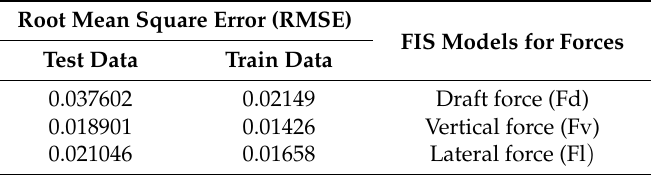
Figure 8. Comparison of predicted data ( a ) with training data and ( b ) with checking data. Table 3. Root mean square error table for training and validation of the models offered.